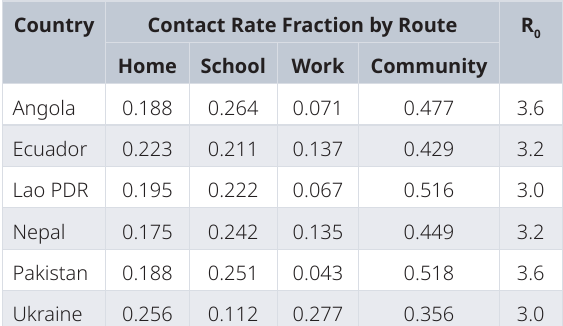
Table 1. Baseline scenario contact rate fraction by route and estimated base reproductive number (R